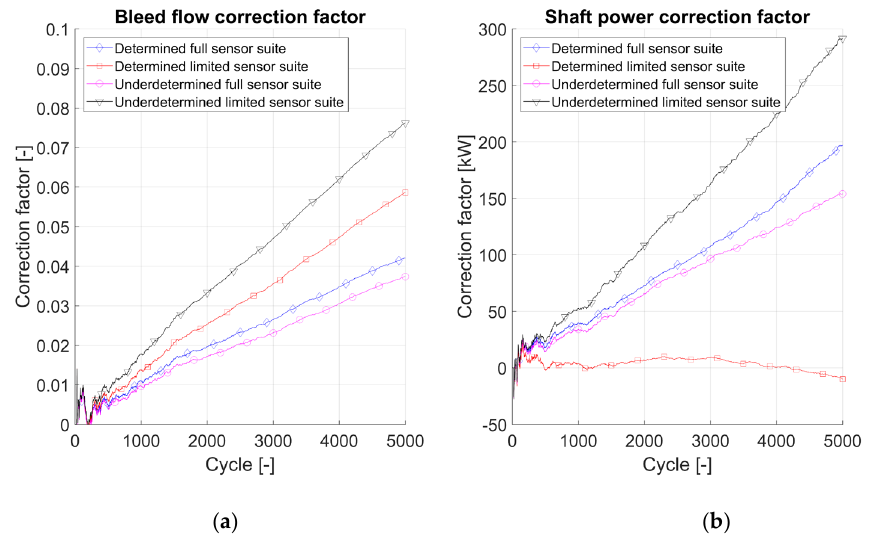
Figure 14. Correction factors, without measurement noise. ( a ) Bleed flow correction factor. ( b ) Shaft power correction factor.